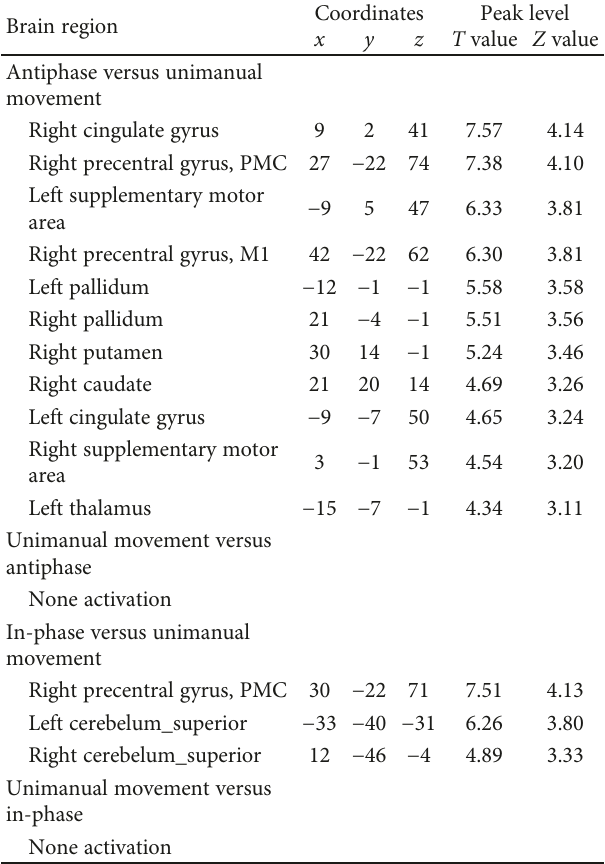
Table 2: Brain areas more activated in performing bimanual movements (antiphase or in-phase) than in performing unimanual movements in the normal subject group separately. Results were thresholded at P < 0 001 and noncorrected.